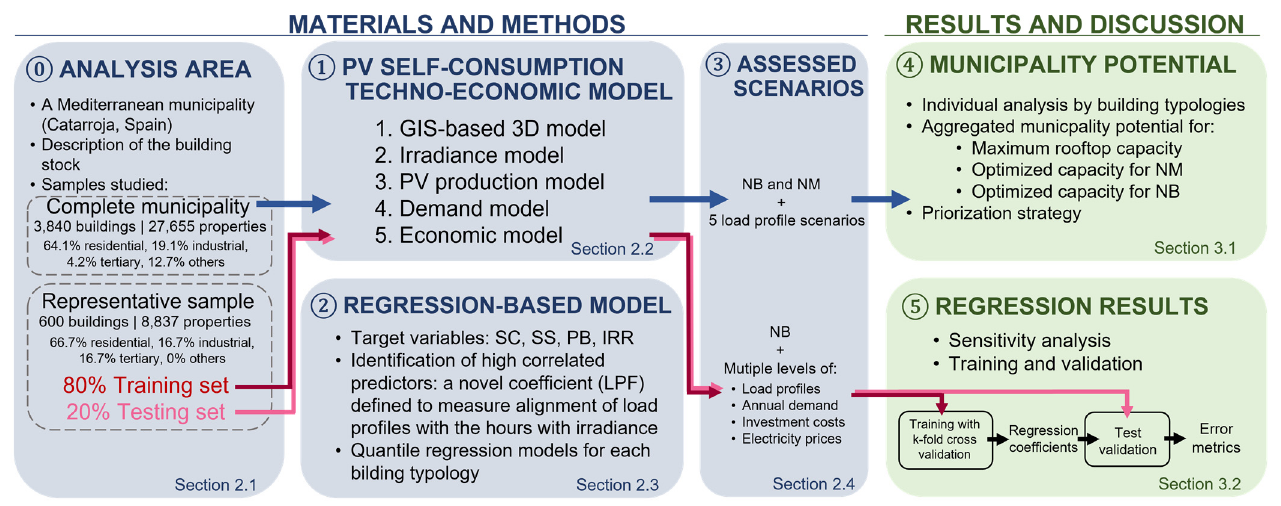
Figure 1. Methodology work fl ow.